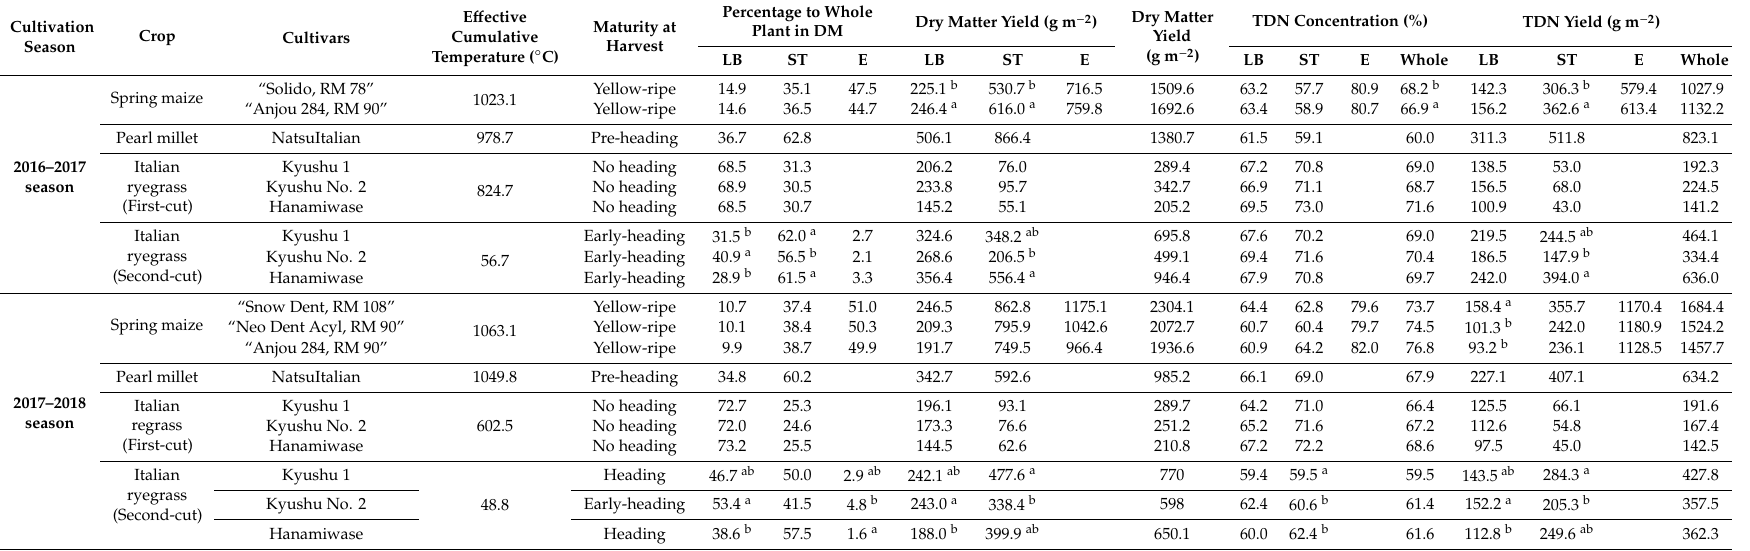
Table 1. Fractionated dry matter proportion, dry matter yield, total digestible nutrients (TDN) concentration, TDN yields and maturity of spring maize, pearl